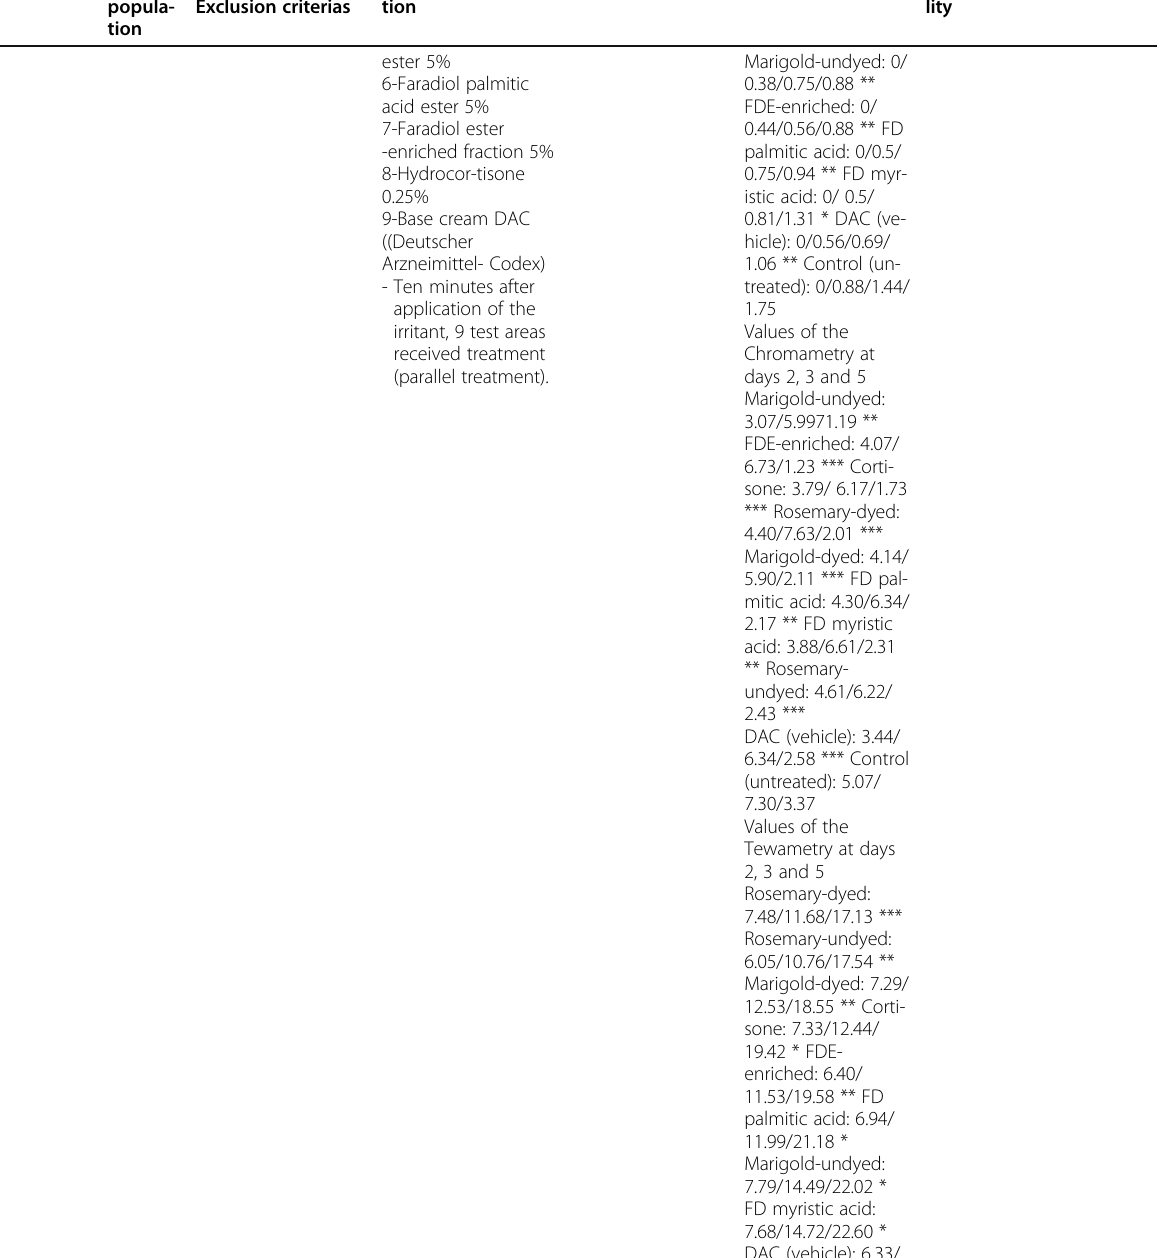
Table 4 Clinical trials of the traditional plants used for skin problems in Turkey (Continued) Study Patient